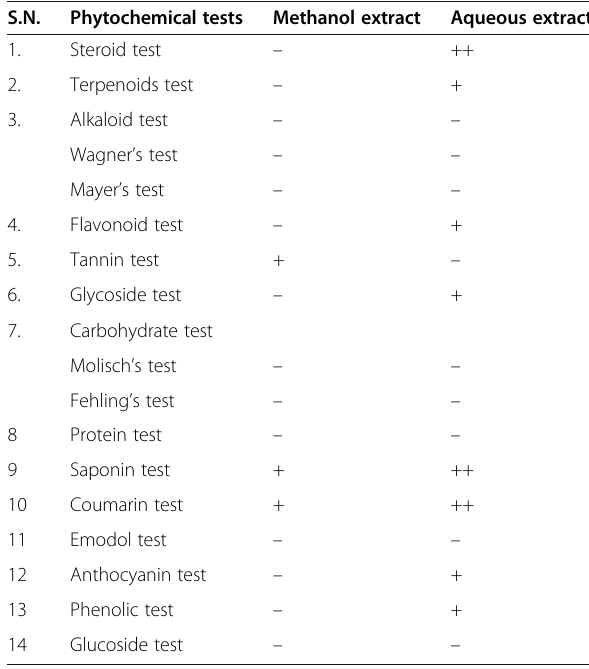
Table 3 Phytochemical results of S. virginianum in methanol and aqueous extract S.N.